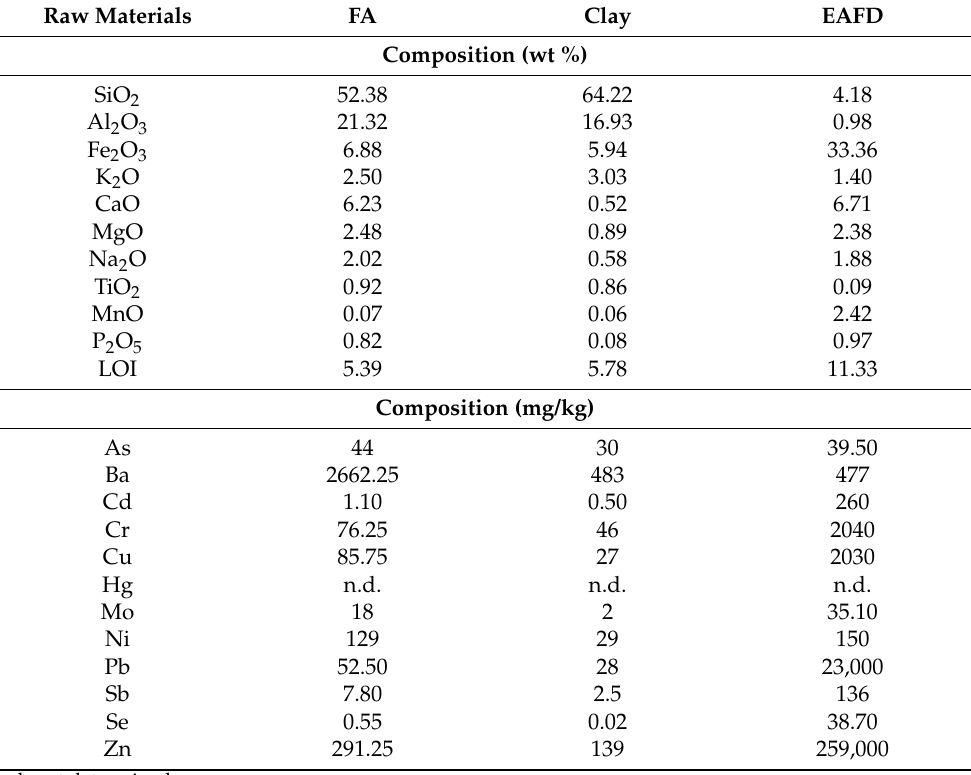
Table 1. Major, minor oxides and trace elements in Fa, clay, and